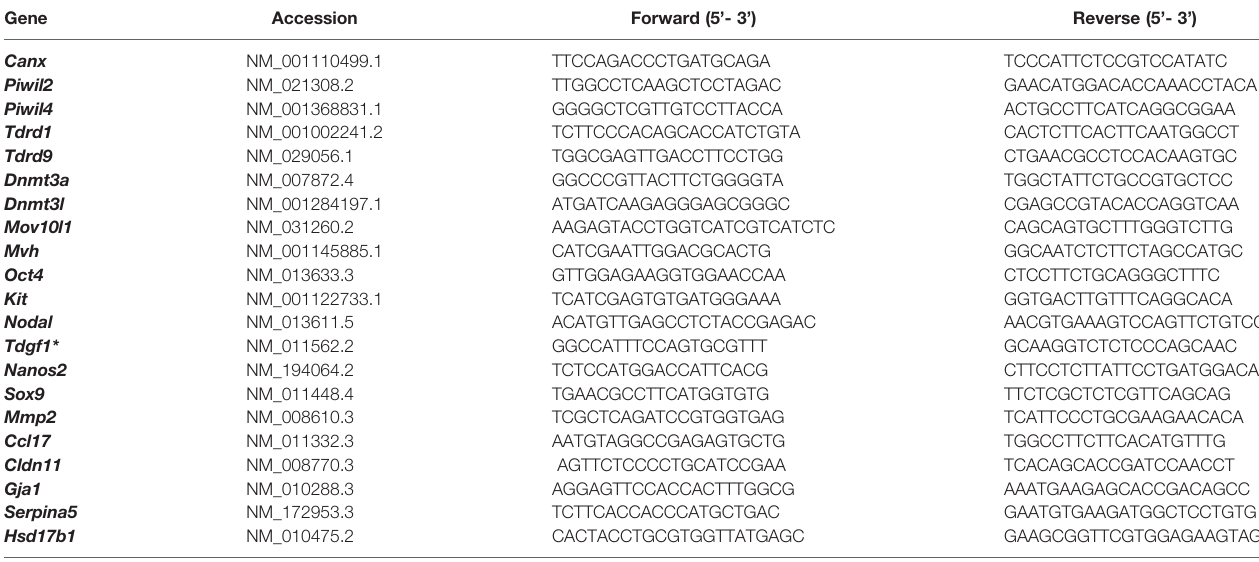
*Souquet et al., (32).